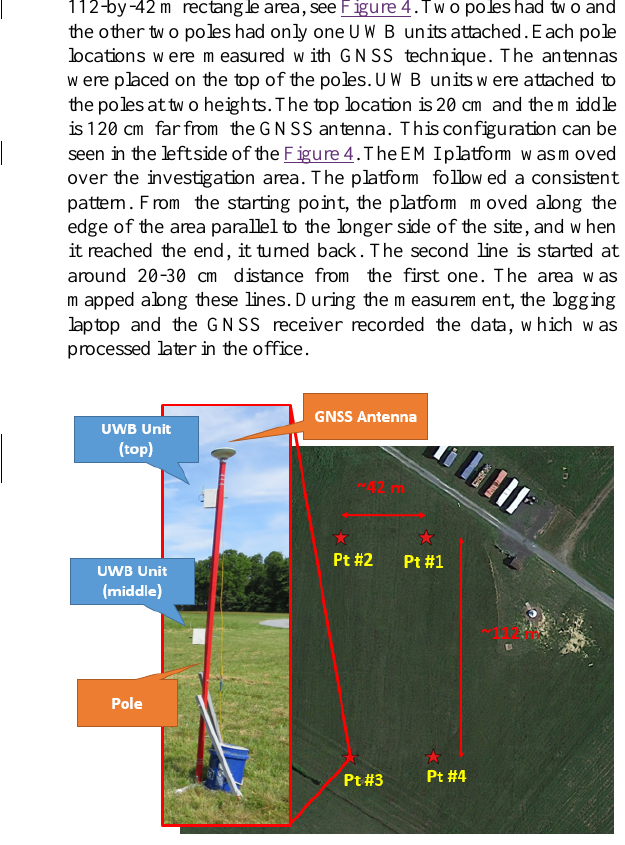
Figure 4. Open-sky test site and UWB network configuration